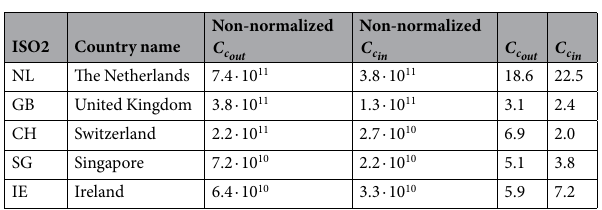
Table 2. List of conduit-OFCs, ordered by value flowing through the conduit toward